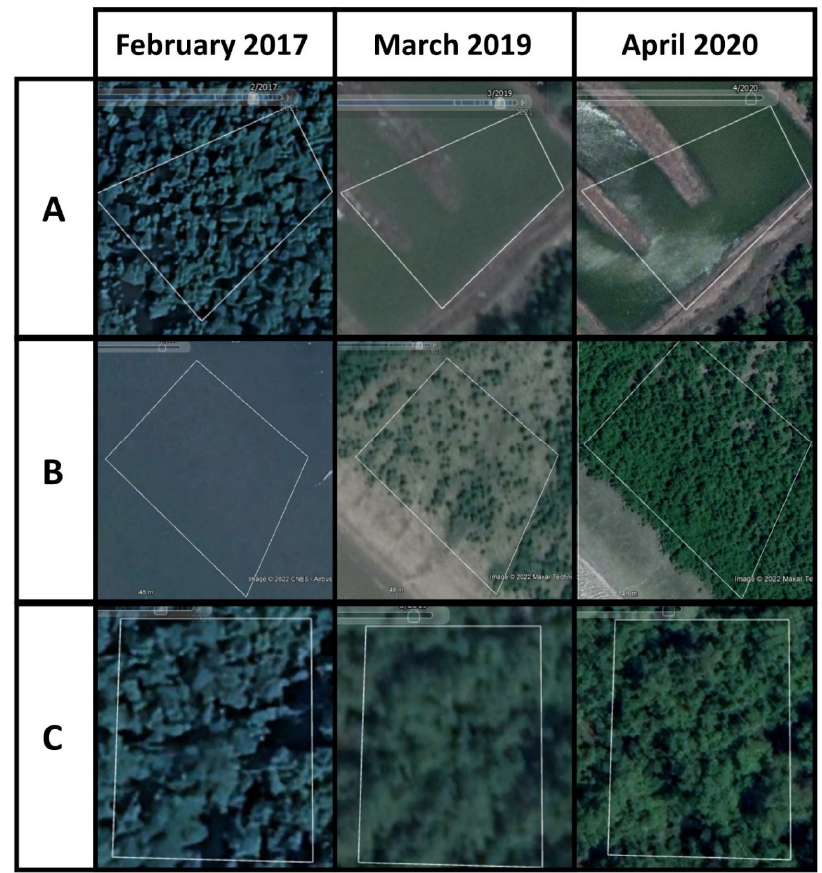
Figure 2. Defining Polygon Samples of Different Mangrove Stages on Google Earth Pro Using Their Historical Imageries ( A ) Disturbance Mangrove Stage Polygon Sample ( B ) Recovery Mangrove Stage Polygon Sample ( C ) Healthy Mangrove Stage Polygon Sample.